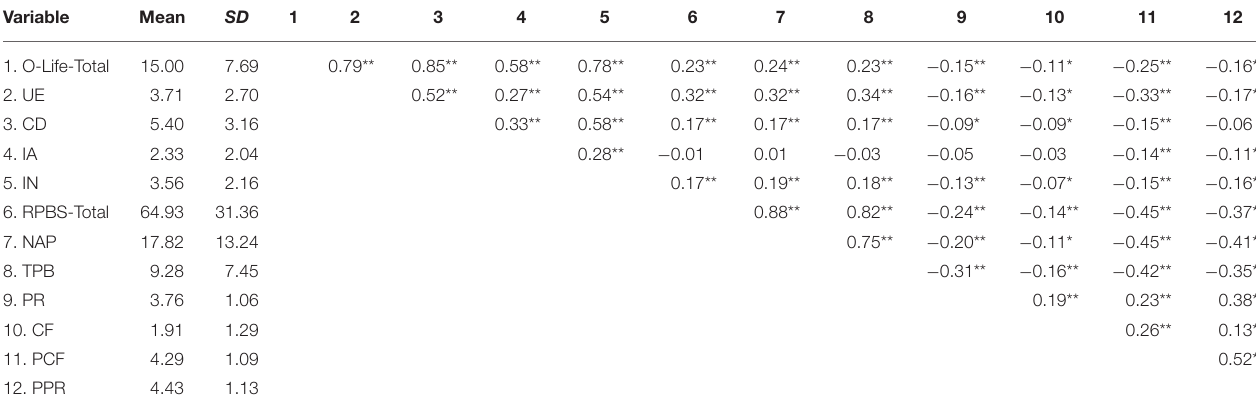
TABLE 1 | Descriptive statistics and intercorrelations among all study variables. Variable